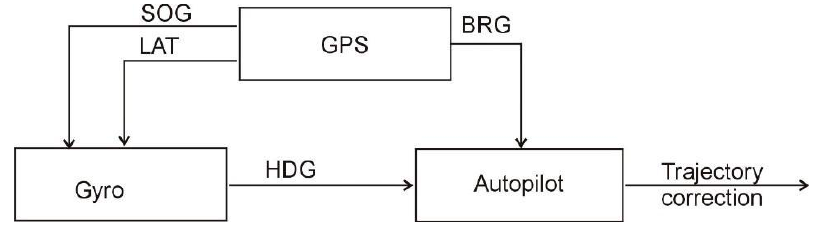
Figure 1. The diagram of information flow for the implementation of route following.